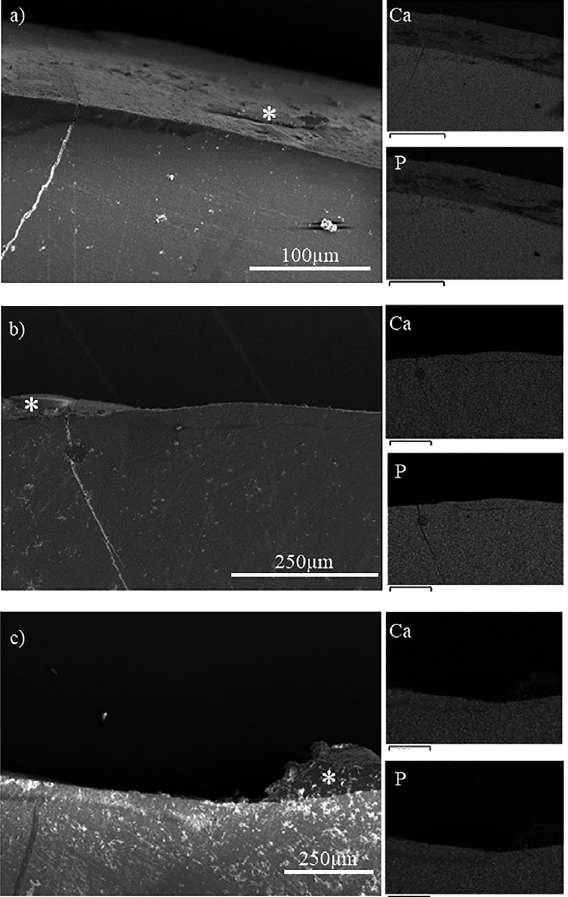
Figure 4- SEM images and the corresponding elemental mapping for calcium and phosphate showing subsurface demineralized regions in a) Durashield, b) F and c) P+F groups. (*: acid resistant film)